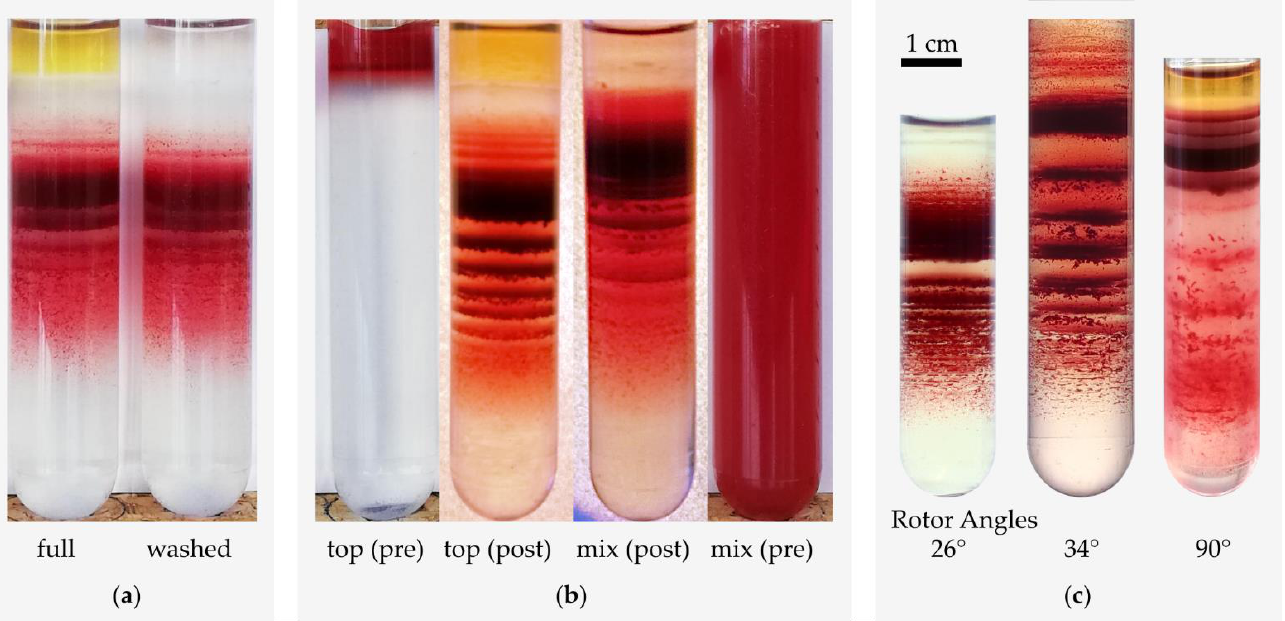
Figure 2. RBCs in self-forming continuous Percoll gradients under various experimental conditions. The scale bar is valid for all panels. ( a ) Distributions of a whole blood sample ( left ) and a washed RBC suspension after simultaneous centrifugation; the samples were loaded on top of the respective Percoll suspension before centrifugation. ( b ) Appearance, before and after centrifugation, of a sample of whole blood that was layered ( left ) on top of the Percoll medium, or homogeneously mixed with it, prior to centrifugation ( right ). In ( a , b ) heparin was used as the anticoagulant at blood withdrawal, and the centrifugation conditions were 20,000 × 𝑔 at 34 °C for 30 min . ( c ) Rotor heads of different angles were used; 90° belongs to the swing-out rotor. Blood samples in ( c ) were different, but all from healthy donors; 34° with heparin, others with EDTA; centrifugation conditions were 20,000 × 𝑔 for 20 min at 25 °C . The different centrifuge models hold tubes different in size and material. This could influence the gradient shape and band formation.